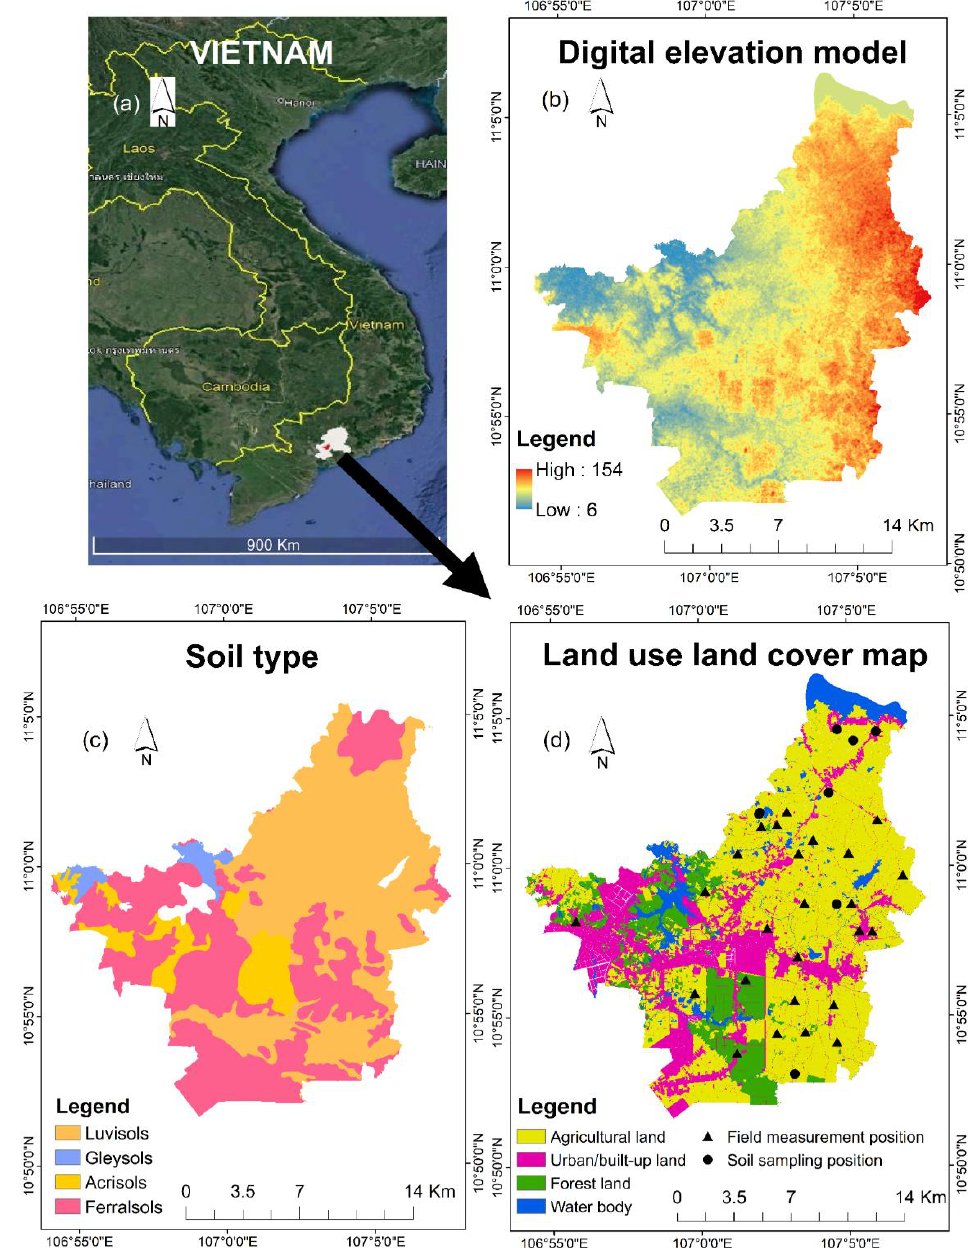
Figure 1. Location of the study area in Vietnam ( a ) and the related information. The digital elevation model (DEM, b ) was obtained from the United States Geological Survey — USGS (https://earthexplorer.usgs.gov/ (accessed on 24 March 2020)). Soil map was obtained from the Department of Agriculture and Rural Development of Dong Nai Province ( c ). Land use land cover map ( d ) was interpreted from the satellite image Sentinel-2 MSI (https://scihub.copernicus.eu/) on 27 February 2020. The triangular points are the soil pH and moisture measuring positions, the circular points are the soil sampling positions.